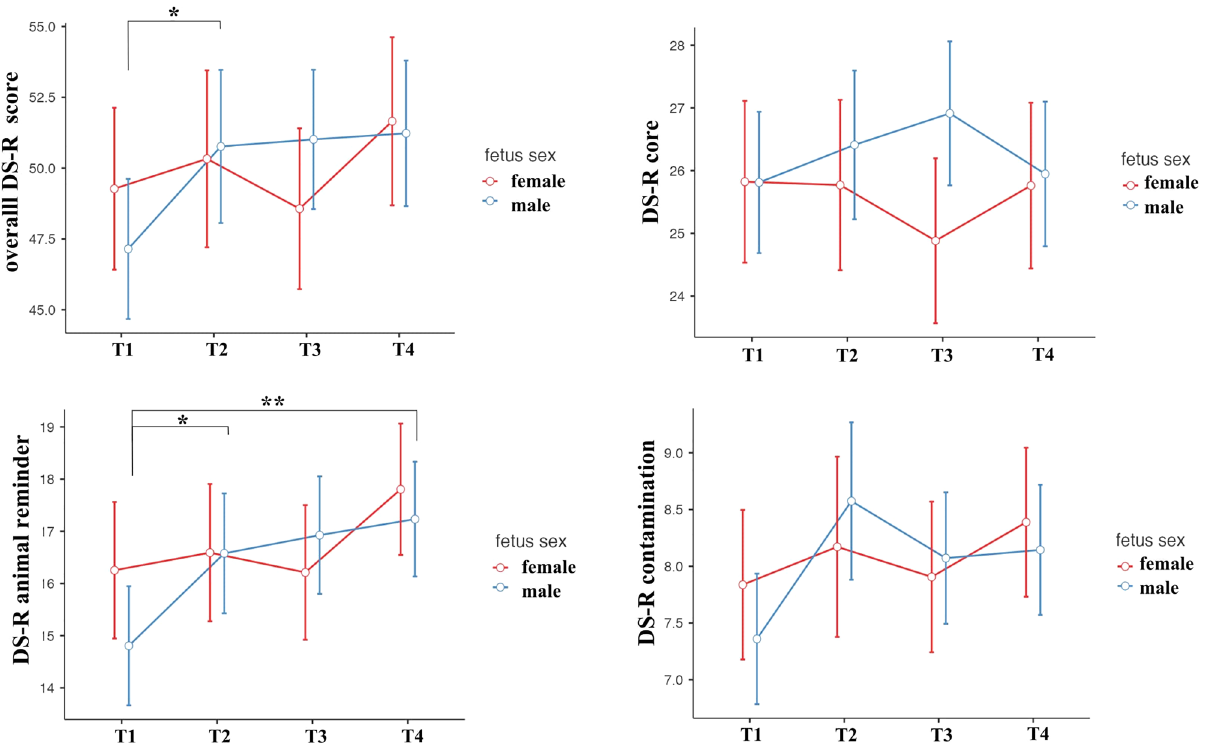
Figure 3. Longitudinal changes during pregnancy and after birth in the overall DS-R score, the core, animal reminder, and contamination subscales, separately for women pregnant with male and female fetus. T1-T3 corresponds to trimester numbers, with T4 being the measurement after birth. The significant differences of disgust sensitivity between periods, results of post hoc tests with the Bonferroni correction, are shown with * p < 0.05 and ** p < 0.01. The graphs show the means and standard errors.